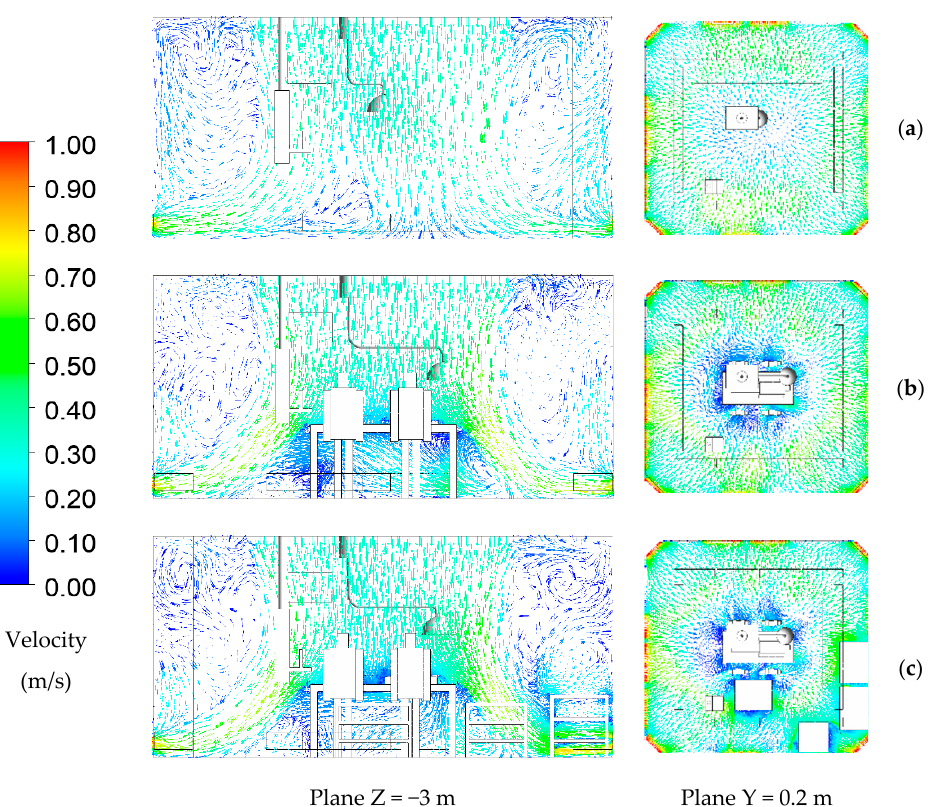
Figure 6. The airflow distribution in different schemes: ( a ) case 1: at-rest condition; ( b ) case 2: operational condition; ( c ) case 3: actual condition.